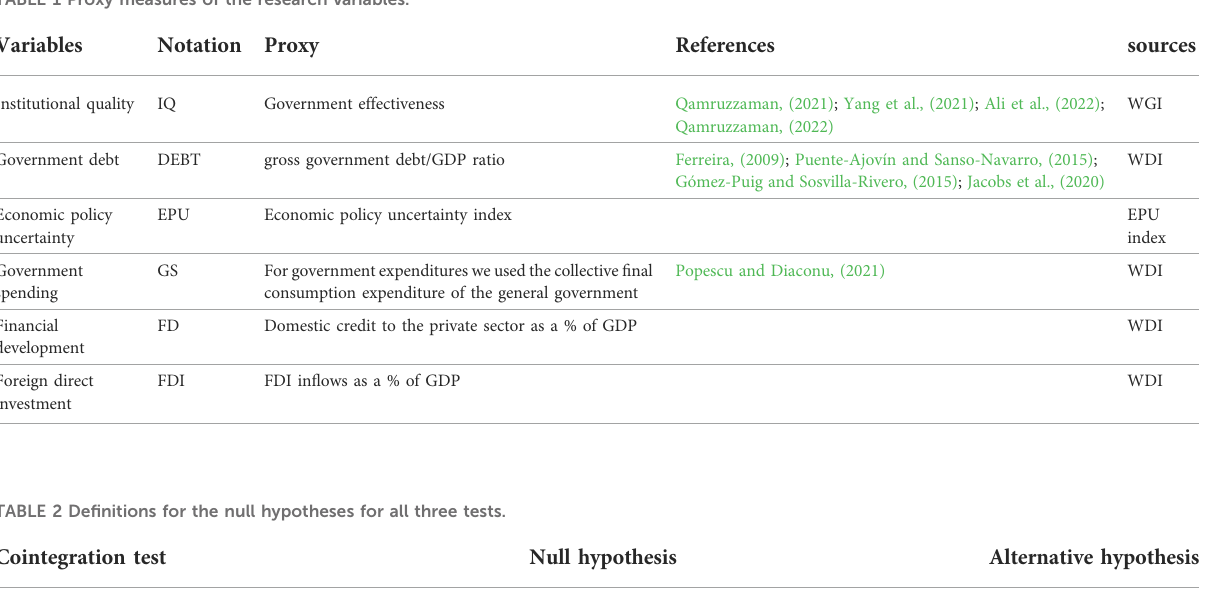
TABLE 1 Proxy measures of the research variables.